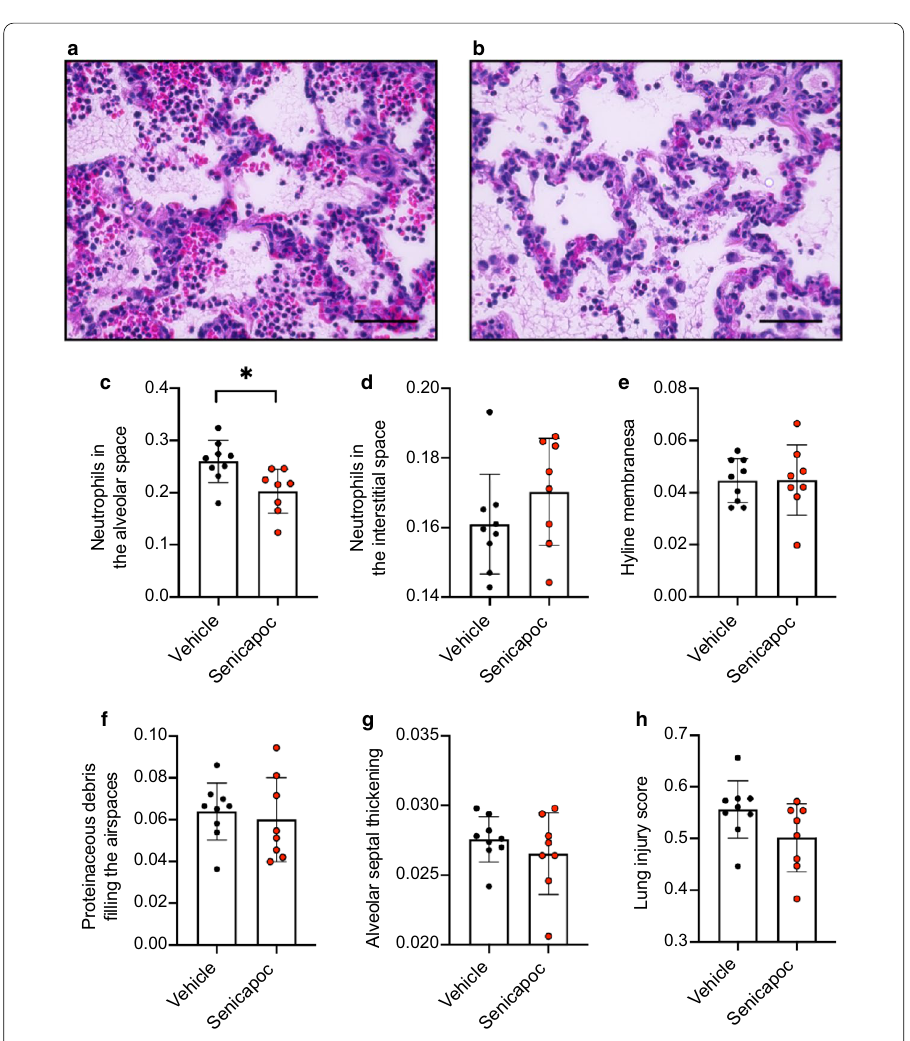
Fig. 5 Senicapoc lowers alveolar neutrophil count, but it does not reduce lung injury score. Representative picture of a vehicle and b senicapoc. Individual scores of c neutrophils in the alveolar space, d neutrophils in the interstitial space, e hyaline membranes, f proteinaceous debris and g alveolar septal thickening, h cumulative lung injury score. Data are presented as mean SD. * P < 0.05 for senicapoc against vehicle. ± Vehicle, n 9 and senicapoc, n 8. The scale in picture A and B indicates 50 = =